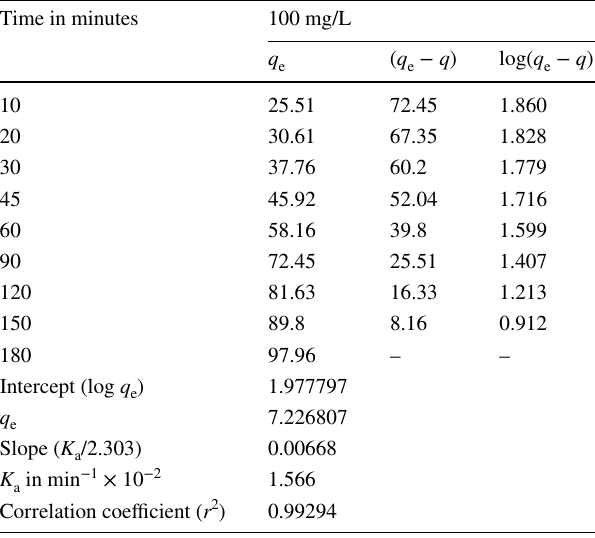
Table 3 Kinetic modelling for adsorption of cadmium(II) from aque- ous solution using Lagergren’s equation (initial concentration of cadmium(II) solution) Time in minutes